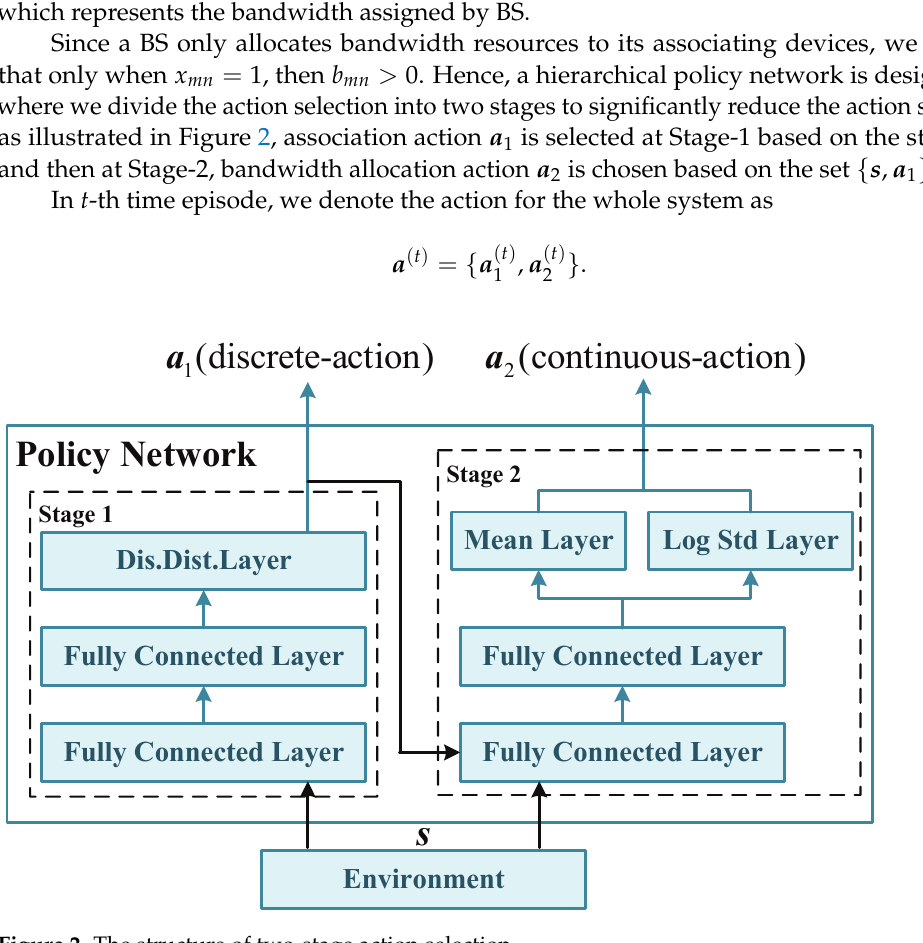
Figure 2. The structure of two-stage action